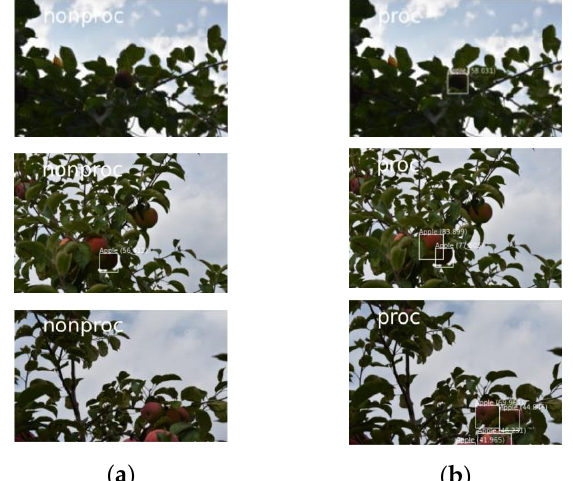
Figure 4. Detecting apples on images with backlight by YOLOv3 without pre-processing ( a ) and with pre-processing ( b ).